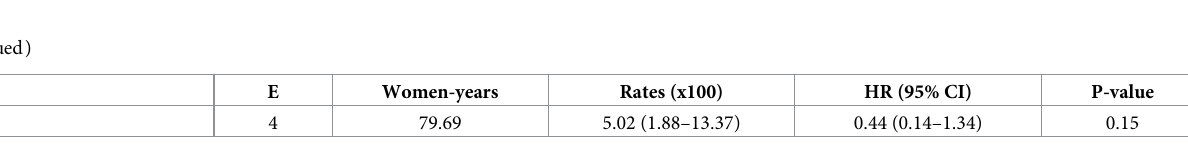
PLOS ONE | https://doi.org/10.1371/journal.pone.0218030 June 20,